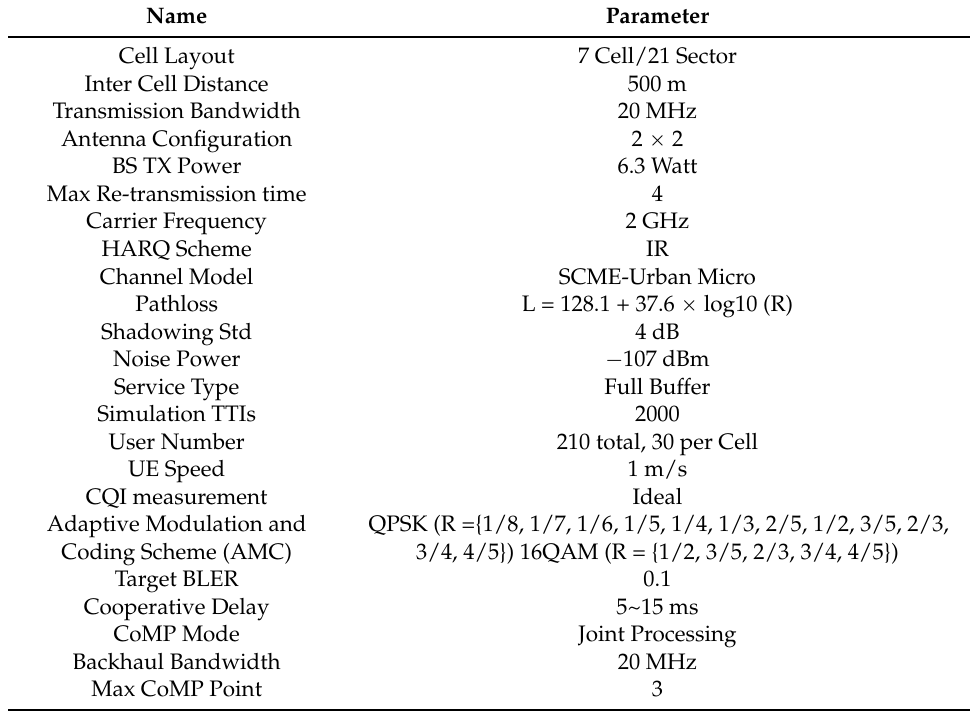
Table 1. Parameters and Assumptions for the Simulation.